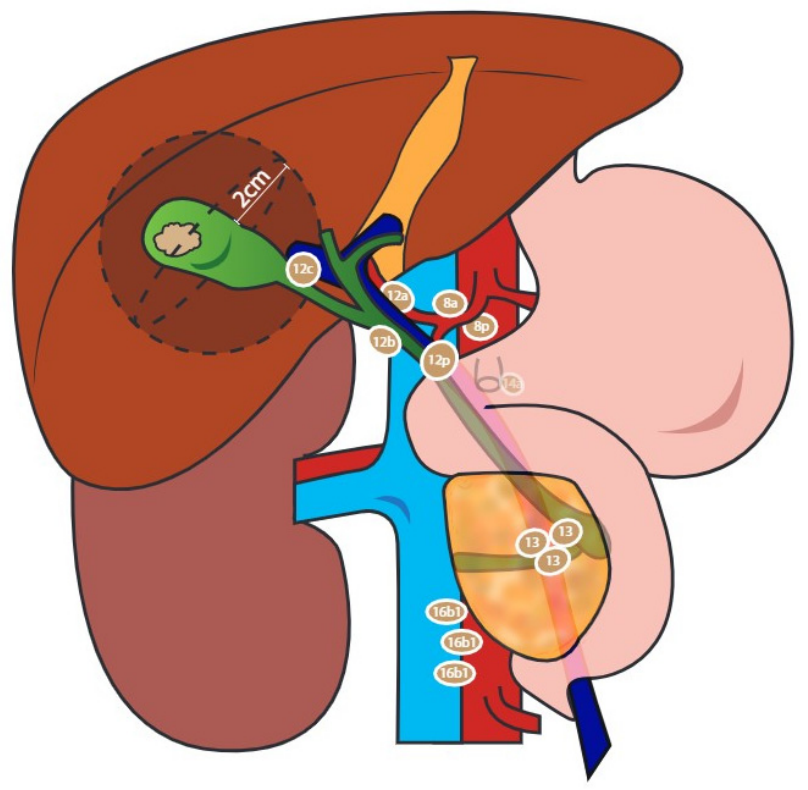
Figure 3. Oncologic extended resection (OER) should include sampling of aortocaval lymph nodes, specifically station 16b1; dissection of the hepatoduodenal ligament (station 12), common hepatic artery (station 8), and retropancreatic lymph nodes (station 13); limited resection of the liver bed or anatomic resection of liver segments IVb and V or rarely major liver resection.